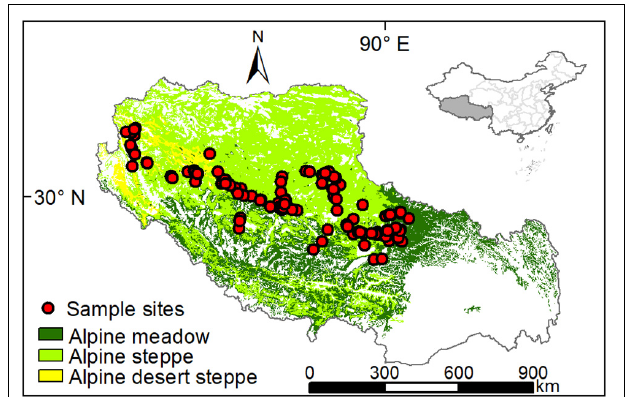
FIGURE 1 | Distribution of grassland types and sample sites in